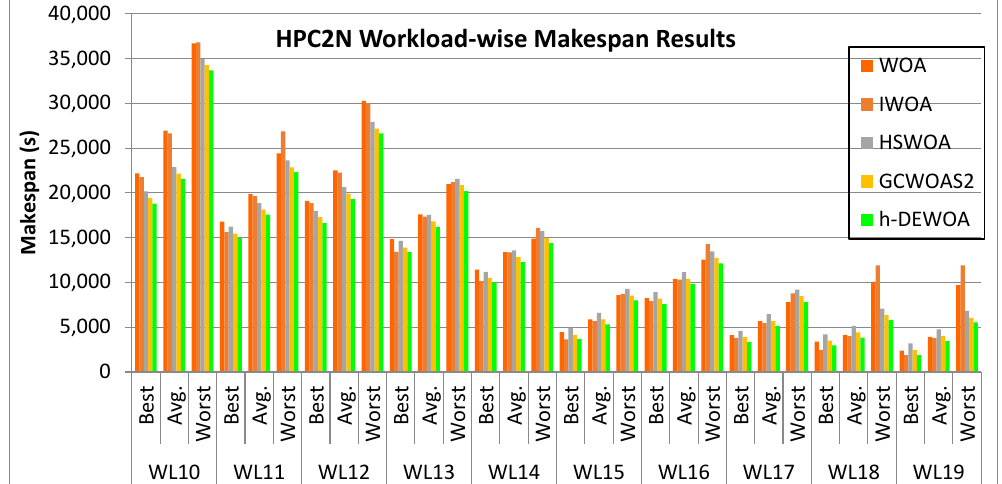
Figure 9. Statistical results of the makespan metric for WL10 – WL19 workloads. Workload-Wise Energy Consumption Results for HPC2N Workloads Figure 10 indicates that the h-DEWOA algorithm produces the minimum best, av- erage, and worst values of the energy consumption for almost every HPC2N workload.